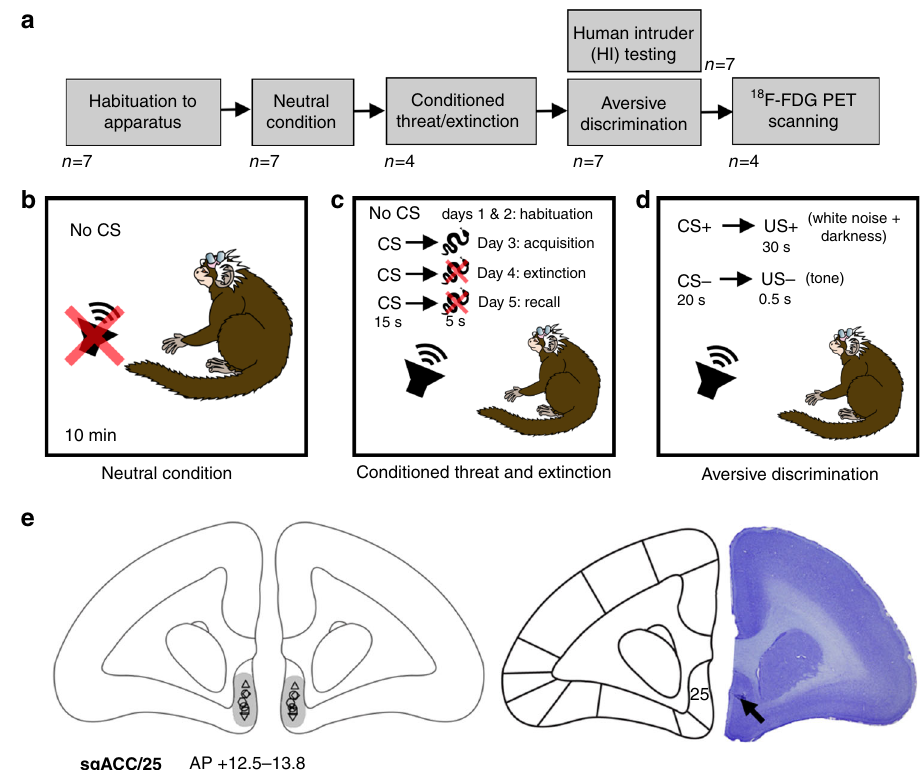
Fig. 1 Experimental timeline, task overview, and histological assessment of cannula placements. a Experimental timeline. All marmosets ( n = 7) were fi rst habituated to the testing apparatus so the context became affectively neutral, after which sgACC/25 infusions were carried out in this neutral condition to assess basal cardiovascular changes. Next, marmosets underwent infusions on the conditioned threat and extinction ( n = 4) and aversive Pavlovian discriminative conditioning ( n = 7) paradigms (see Table 1 for details). Human intruder (HI) testing ( n = 7) was interleaved with aversive discrimination testing. Finally, four marmosets underwent 18 F-FDG PET scanning. b In the neutral condition, no CSs were presented. c In the Pavlovian conditioned threat and extinction paradigm, habituation occured over the fi rst two days; learning of the CS (auditory cue)-US (rubber snake) association occurred over the third acquisition day; and on the subsequent extinction and extinction-recall days (days four and fi ve), the cue was presented without the snake. d In the aversive Pavlovian discriminative conditioning paradigm, marmosets learned to distinguish between a threatening auditory cue (CS + ) predicting aversive white noise and darkness (US + ), and a safety auditory cue (CS − ) predicting a neutral tone (US − ). e Histological assessment of cannula placement using cresyl-violet staining. No damage was noted in any animals aside from the small area of gliosis used to pinpoint cannula placement. A schematic diagram, left, shows the cannula placement for all marmosets reported in the manuscript (anteroposterior [AP] extent between + 12.5 and + 13.8 mm from interaural line, diagram centered around + 13.0mm) together with the estimated spread of infusion in gray (0.5 – 1.0mm). A representative cresyl-violet stained histological section is shown right, with the cannulation site indicated by an arrow.